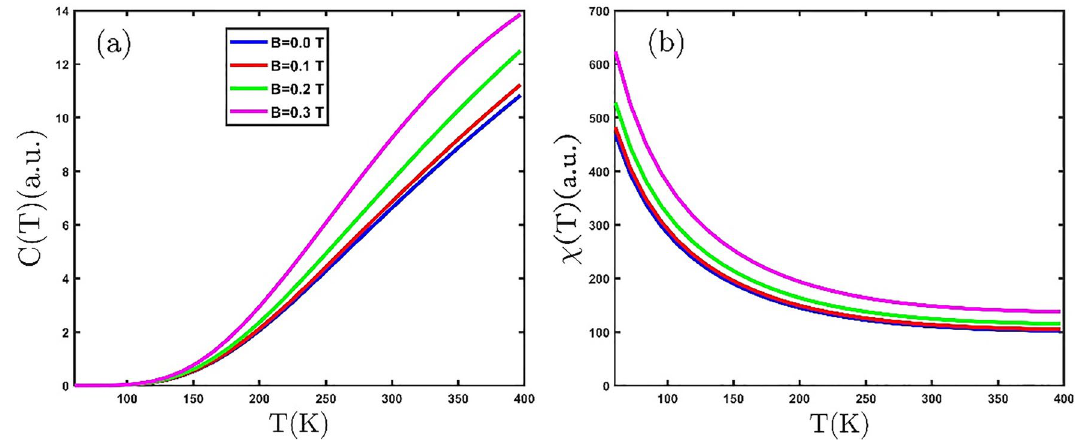
Figure 3. ( a ) The electronic heat capacity ( b ) magnetic susceptibility of the GeCH 3 SL versus temperature for various external magnetic fields.